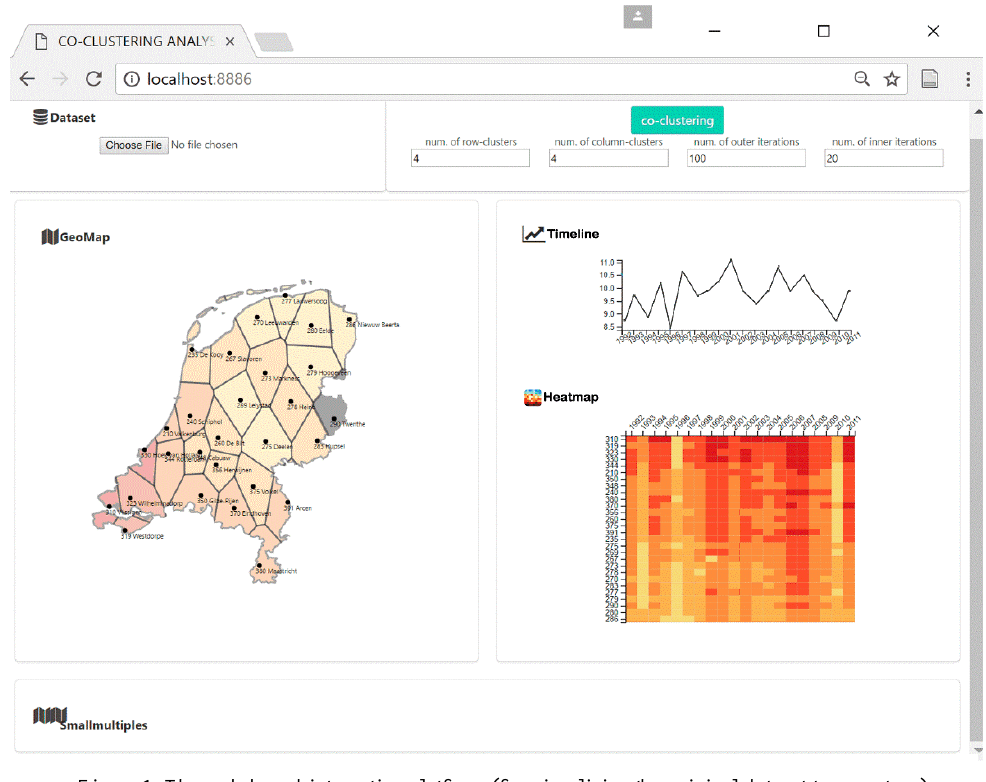
Figure 1. The web-based interactive platform (for visualizing the original dataset